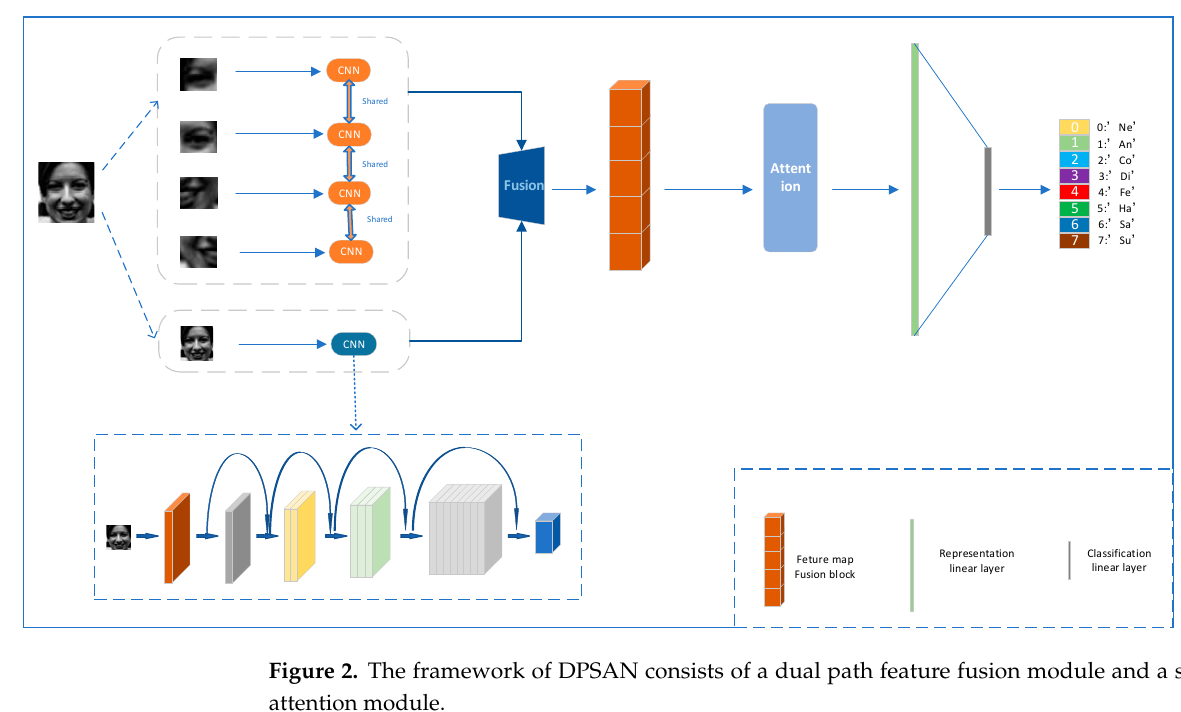
Figure 2. The framework of DPSAN consists of a dual path feature fusion module and a stacked attention module.